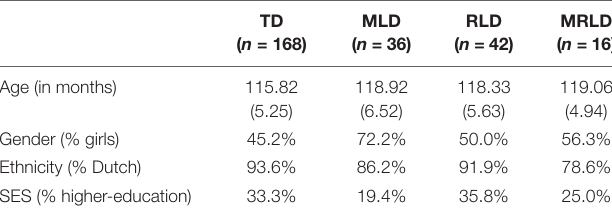
TABLE 1 | Background characteristics for the TD, MLD, RLD, and MRLD